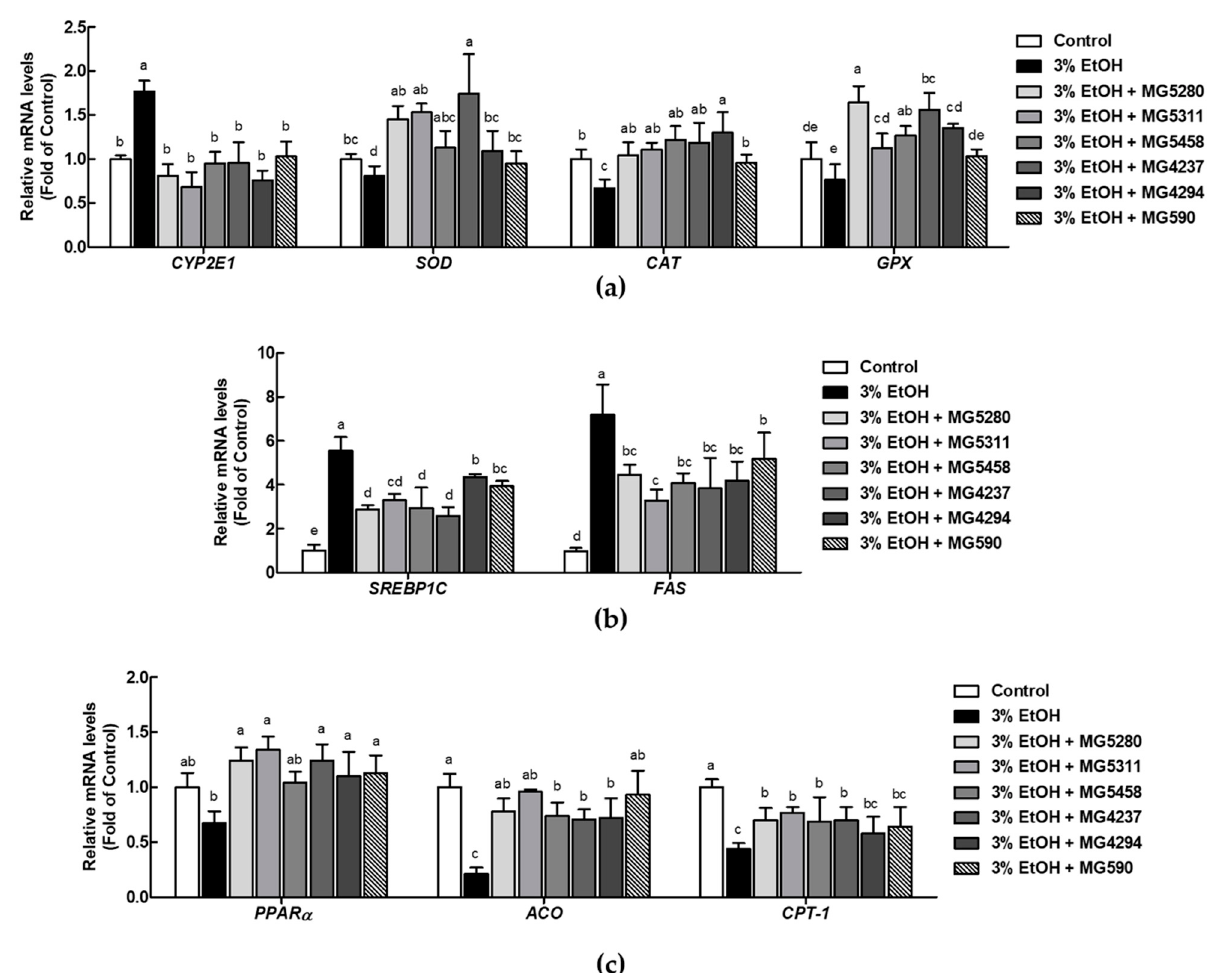
Figure 5. Effect of CFEs (100 µg/mL) from LAB strains on mRNA expression of ( a ) CYP2E1 and antioxidant enzymes ( SOD , CAT and GPX ), ( b ) lipid synthesis factors ( SREBP1C and FAS ), and ( c ) lipid oxidation factors ( PPAR α , ACO and CPT-1 ). Data are expressed as the mean ± SD ( n = 3). Different letters on the column indicate significance at p < 0.05 based on Duncan’s test. EtOH, ethanol.